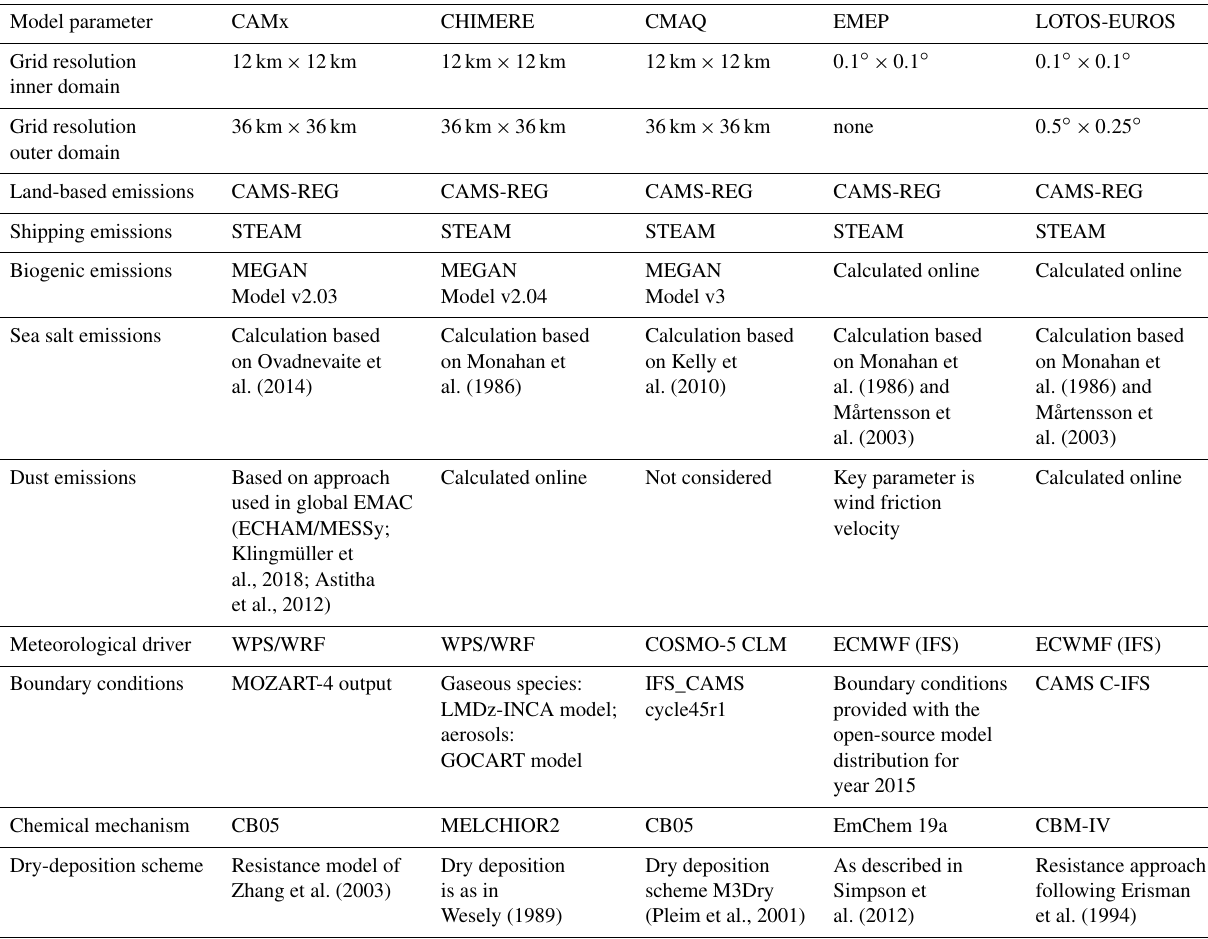
Table 1. Main model parameters and input data for the five chemical transport